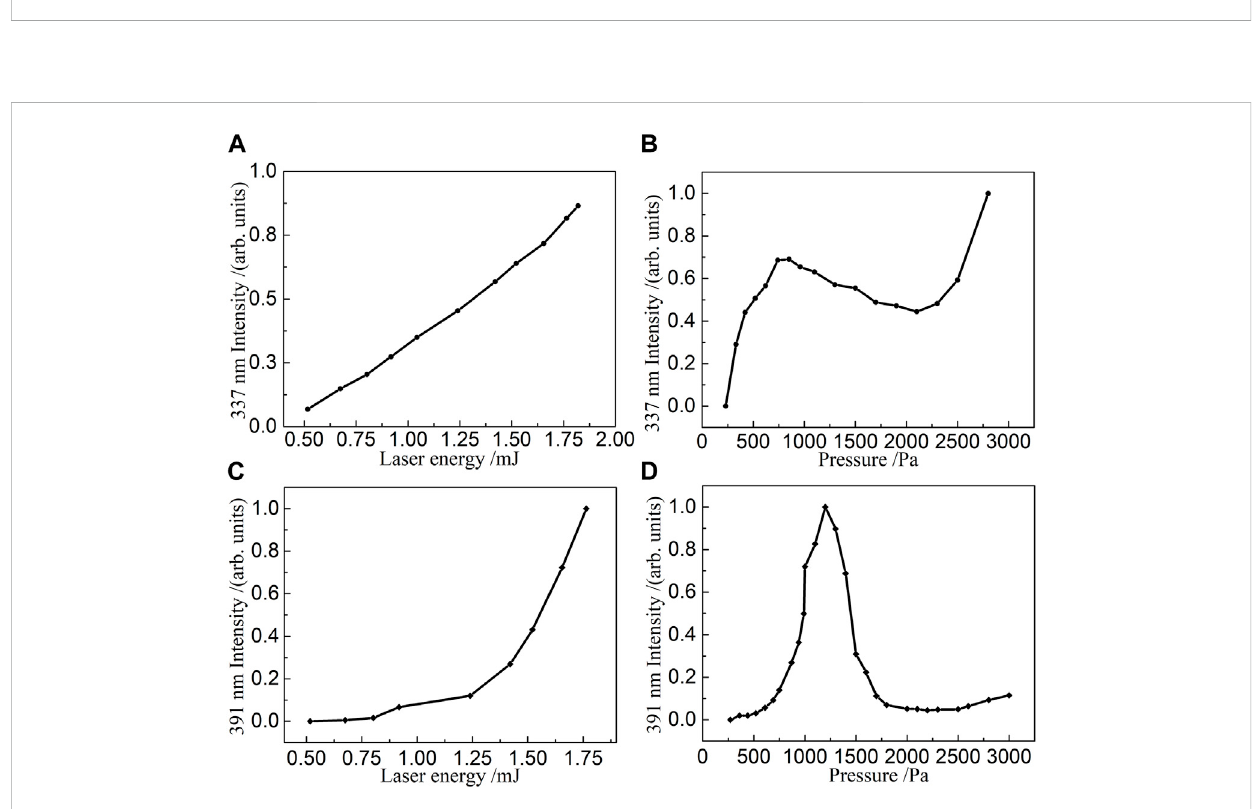
FIGURE 2 In the case of n = 0 (A) Intensity of the fl uorescence emission at 337 nm as a function of the incident pulse energy with the nitrogen gas pressure of 1,200 Pa (B) Intensityofthe fl uorescenceemission at337 nmasafunctionofthenitrogengaspressurewiththepulseenergyof1.25 mJ. (C,D) issameas (A,B) , respectively, but for the lasting emission at 391 nm. For a better comparison, the maximum of each intensity curve is normalized to